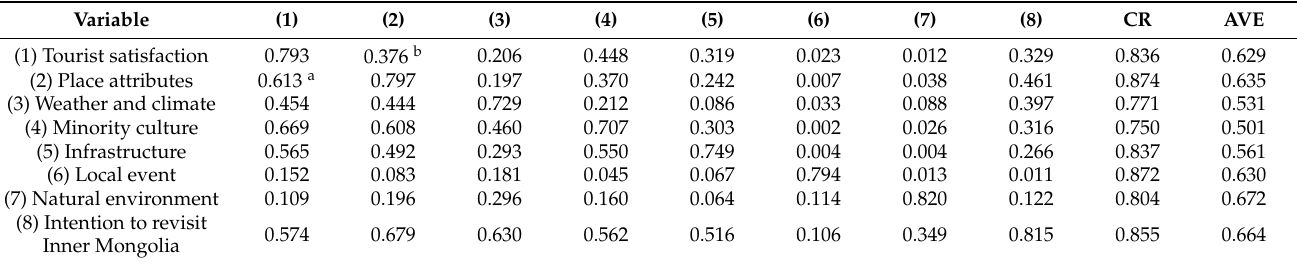
Table 3. Summary of the confirmatory factor analysis result.